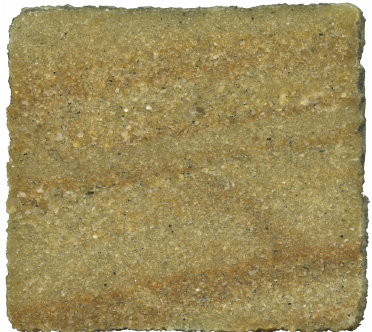
Figure 2. Nehvizdy sandstone sample captured using high-resolution flatbed scanner.